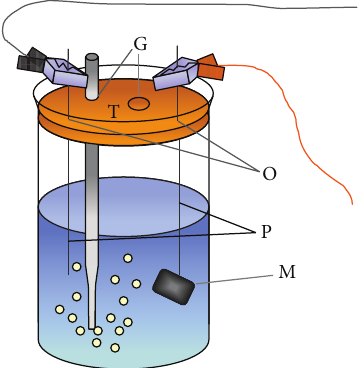
Figure 1: Scheme of electrochemical cell. T: rubber stopper; G: